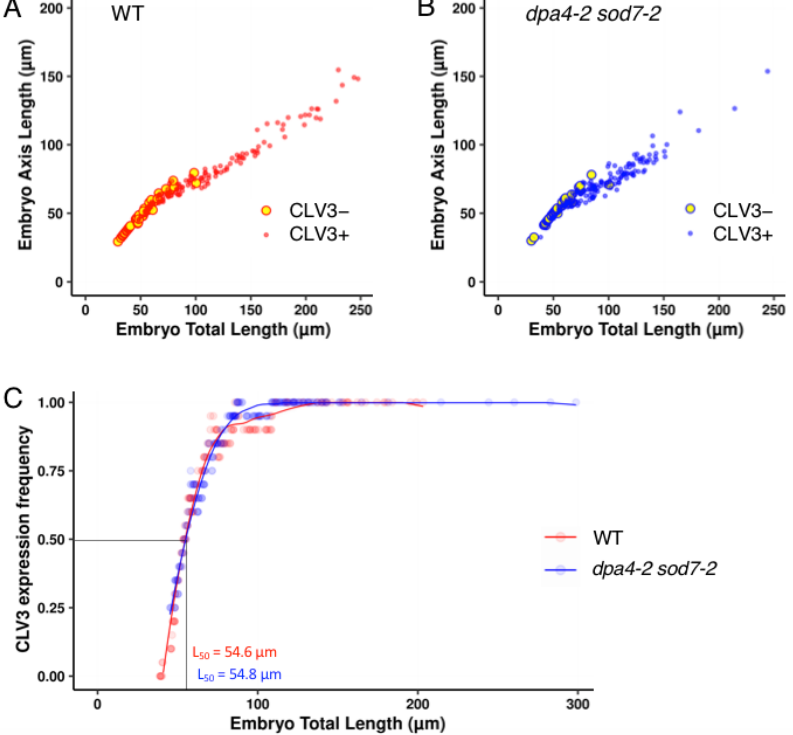
Figure 2. Dynamics of pCLV3:mCHERRY-NLS activation in developing wild-type and dpa4-2 sod7-2 embryos. ( A ) Wild-type embryos not expressing pCLV3:mCHERRY-NLS (large yellow circles with red outline) or expressing it (small red dots) were plotted in a morphospace with embryo total length along the x-axis and embryo axis length along the y-axis. ( B ) dpa4-2 sod7-2 embryos not expressing pCLV3:mCHERRY-NLS (large yellow circles with blue outline) or expressing it (small blue dots) were plotted in a morphospace with embryo total length along the x-axis and embryo axis length along the y-axis. ( C ) Model of pCLV3:mCHERRY-NLS activation during wild-type (red) or dpa4-2 sod7-2 (blue) embryo development. The dots represent the average of the frequency of pCLV3:mCHERRY-NLS-expressing embryos calculated on a 20 embryo-wide sliding window. The red and blue lines represent curves fitted on these points. The total embryo length at which half of the embryo expressed pCLV3:mCHERRY-NLS (L 50 ) was calculated (shown with dotted black lines). Altogether, our analysis could not reveal any difference in the timing of pCLV3:mCHERRY- NLS activation during embryo development, whether staging the embryos on morphologi- cal features or on their